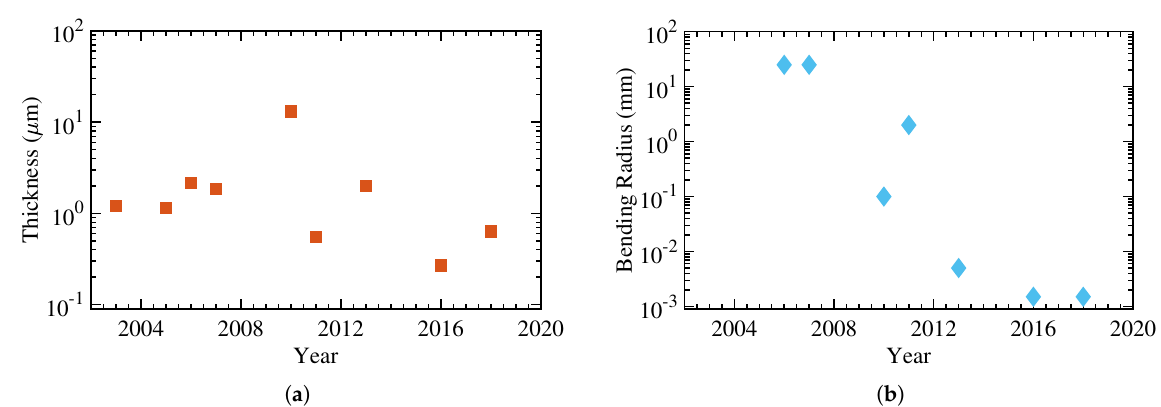
Figure 11. The progress of organic TFTs with ( a ) the total thickness and ( b ) the bending radius.